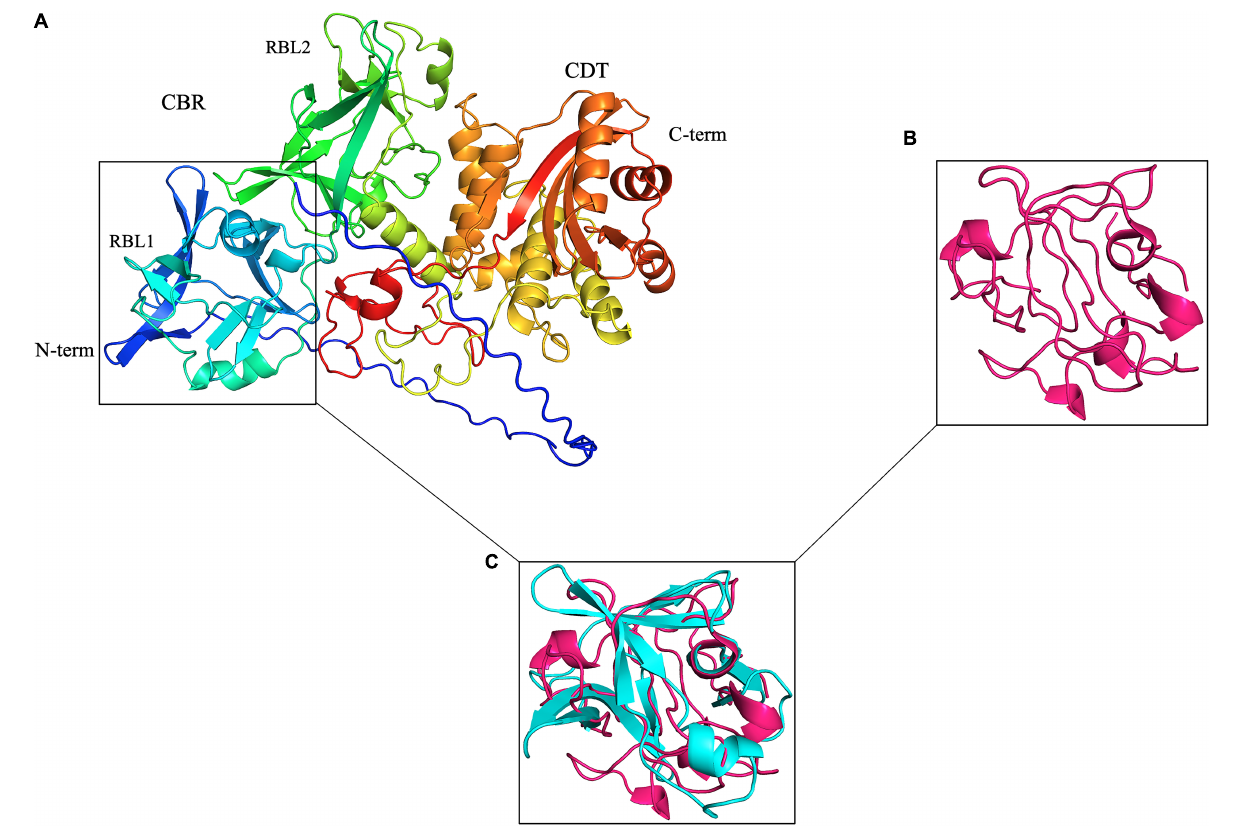
FIGURE 1 | Leptospira PF07598 gene family members, represented by LA3490 here, are predicted with high confidence to have two tandemly repeated, N-terminal ricin B-like (RBL) lectin domains. (A) Visualization of an AlphaFold 3D-generated model of full-length LA3490 (Callaway, 2020; Jumper et al., 2020; Senior et al., 2020) showing four globular domains N-terminal to C-terminal (blue to red color) residues visualized in PyMOL 2.4.0 https://pymol.org/2/. Phyre2 (Protein Fold Prediction Server; http://www.sbg.bio.ic.ac.uk/phyre2/html/page.cgi?id=index) had first predicted, with high ( > 94%) confidence, that LA3490, as well as all other virulence-modifying (VM) proteins encoded by the PF07598 gene family, contains N-terminal β -trefoil folds identified as ricin B domains. (B) Ricin B domain (PBD; 2AAI-B, 7 aa to 129 aa). (C) Superimposition of 2AAI-B and N-terminal region of LA3490 (i.e., amino acid positions 40–150) was performed using PyMOL (TM) 2.4.0 showing structural conservation of RBL1 and the B chain of ricin (RMSD = 1.796